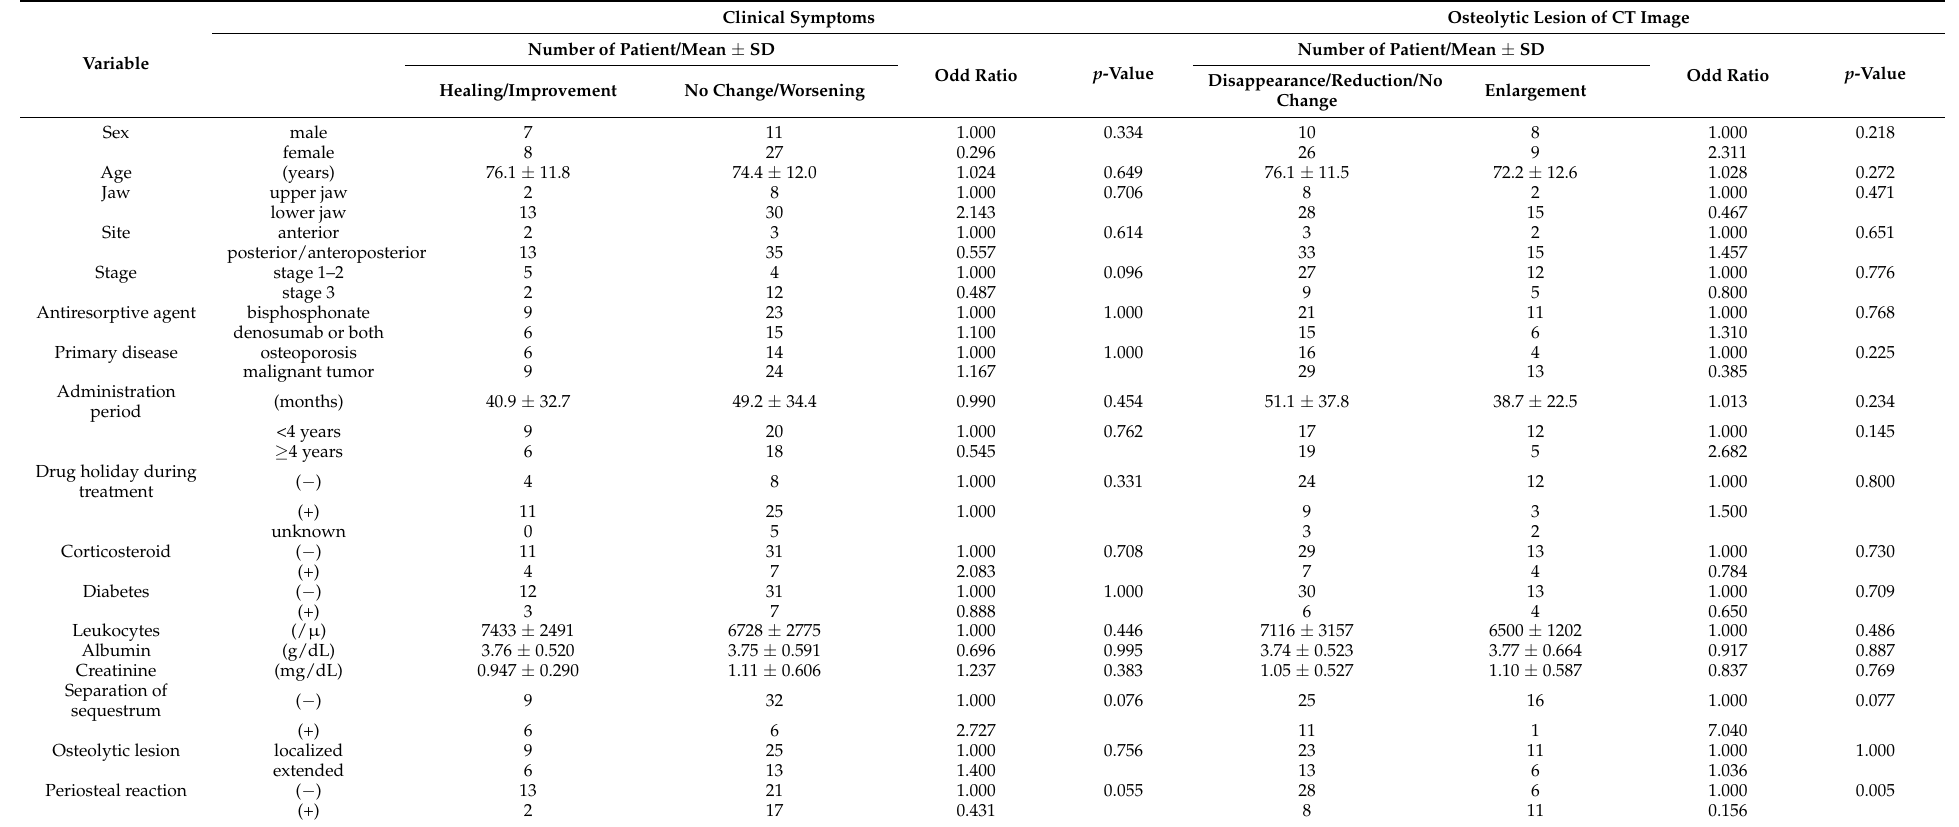
Table 3. Factors related to treatment